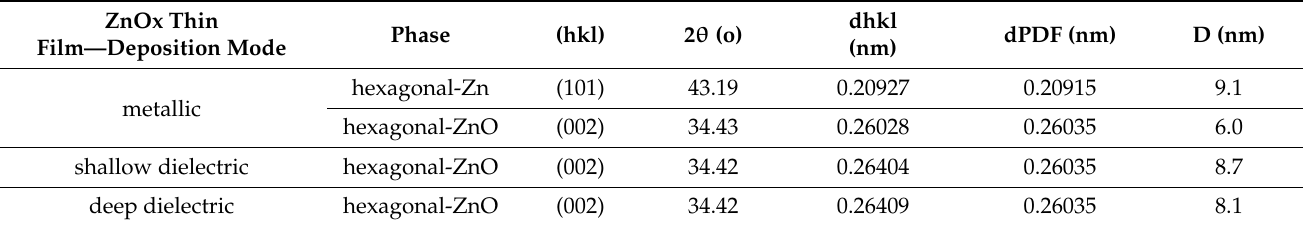
Figure 5. Diffraction patterns of ZnOx thin films deposited in metallic mode (a) work point, shallow dielectric mode (c1) work point and deep dielectric mode (c2) work point. Table 1. Summary of XRD investigations of ZnOx thin films.